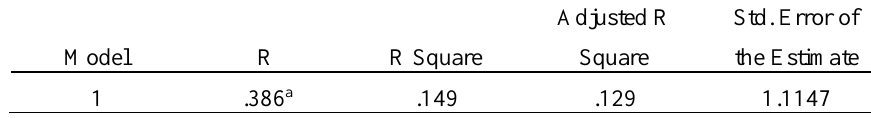
Model summary rendering the multiple correlation coefficients, the adjusted and unadjusted R of self-efficacy and self-esteem, with academic achievement Adjusted R Model R R Square